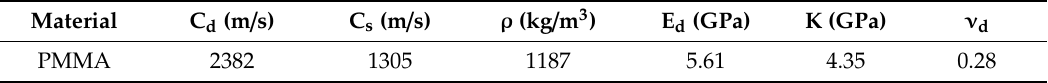
Figure 3. Non-metallic acoustic detector. Table 3. Material parameters of polymethyl methacrylate (PMMA).